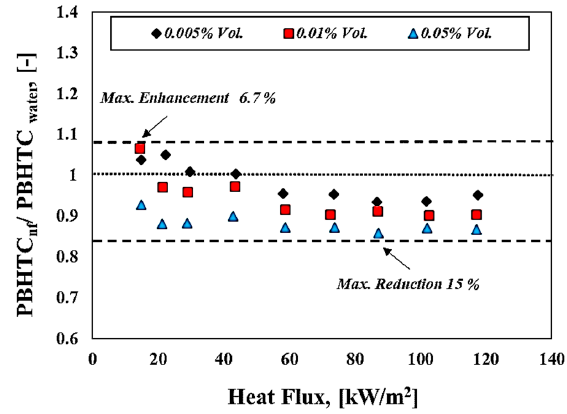
Figure 10. Pool boiling heat transfer coe ffi cient against heat flux of WO 3 -based water nanofluids at di ff erent volume fractions.